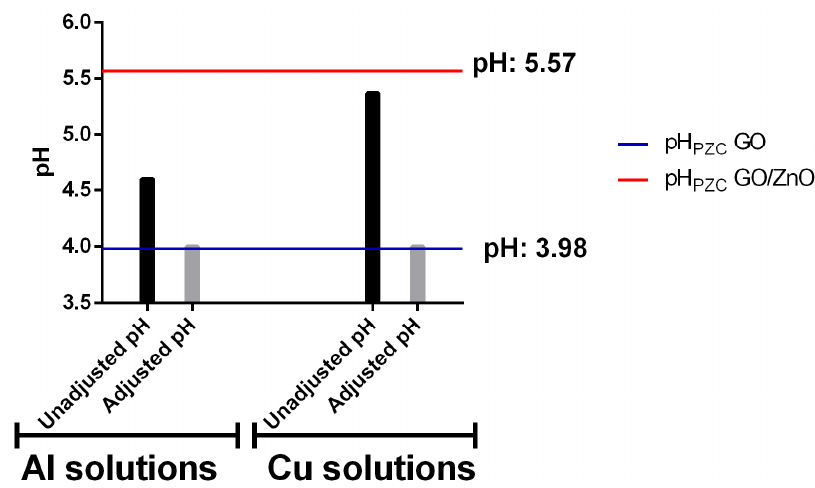
Figure 3. The pH values for Al and Cu monometallic solutions for experiments with and without pH adjustment. The blue line indicates the pHPZC for GO and the red line for GO/ZnO.